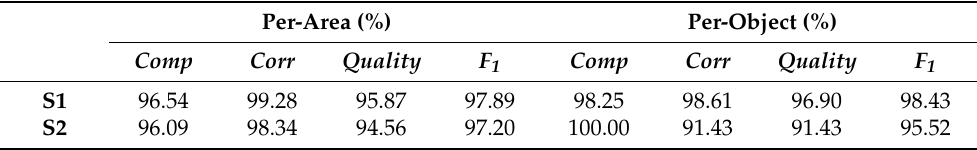
Figure 11. Building extraction results of OpenTopography datasets. ( a ) The building extraction result for S1; ( b ) the reference building extraction results of S1 from orthophoto image; ( c ) the building extraction result for S2; ( d ) the reference building extraction results of S2 from orthophoto image. Yellow represents correctly extracted buildings ( TP ), red represents wrongly extracted buildings ( FP ), and blue represents omitted buildings ( FN ). Table 4. Accuracy of building extraction in OpenTopography datasets.